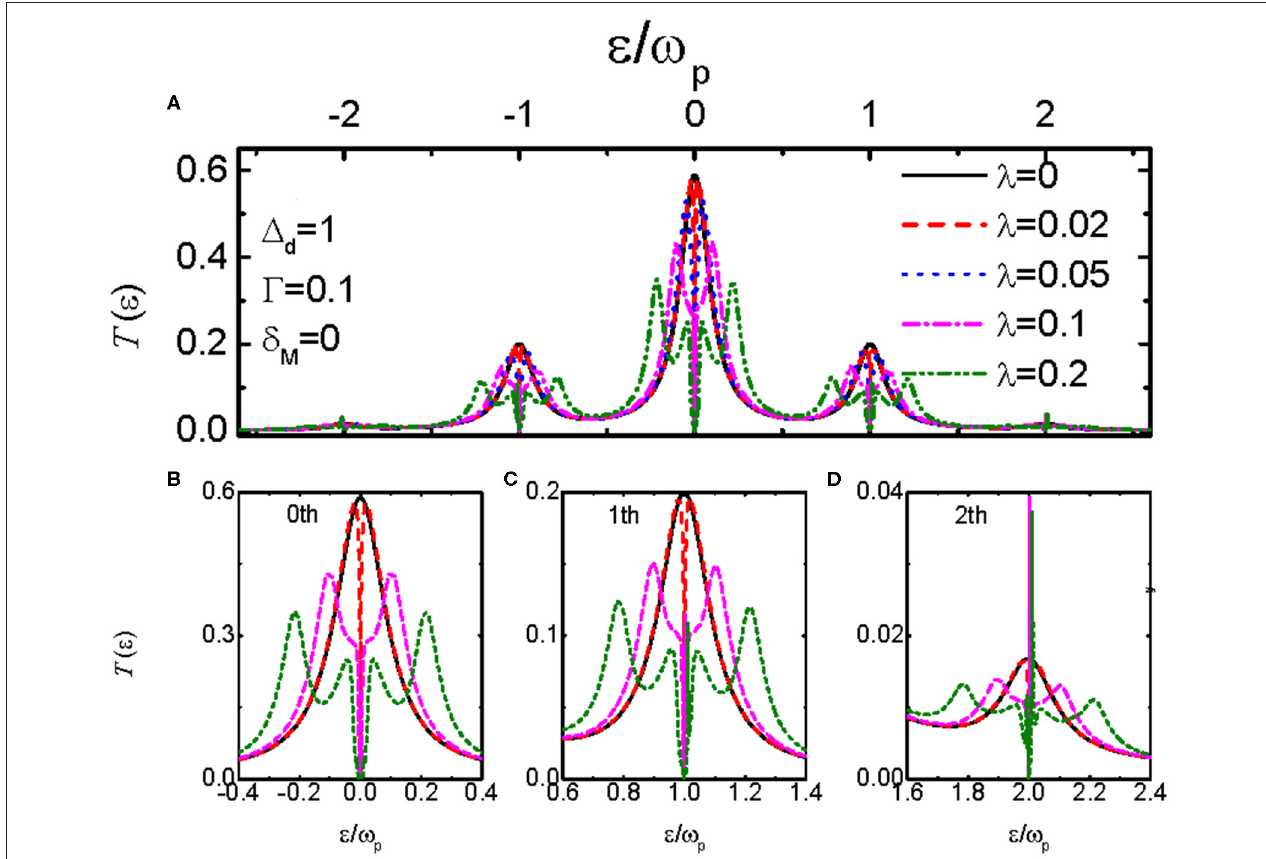
ω p , and different values of the =